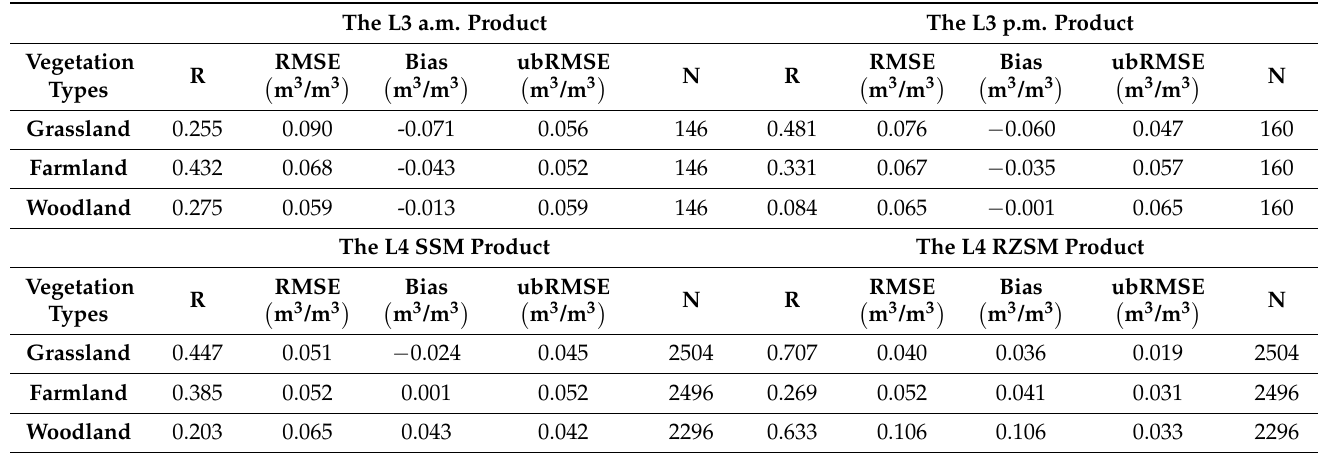
Table 2. Comparison of the SMAP SM L3 and L4 products in the SMN-SDR Basin under different vegetation covers. The L3 a.m. Product The L3 p.m.